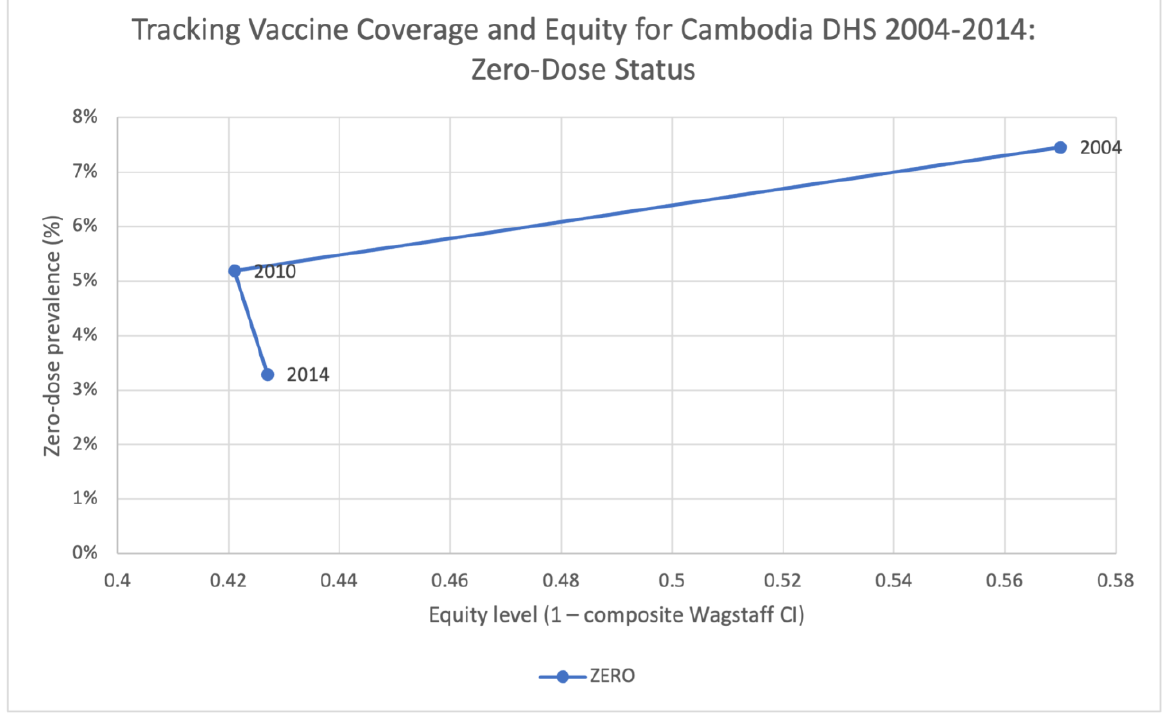
Figure 4. Tracking vaccine coverage and equity for Cambodia DHS 2004–2014: ZERO.